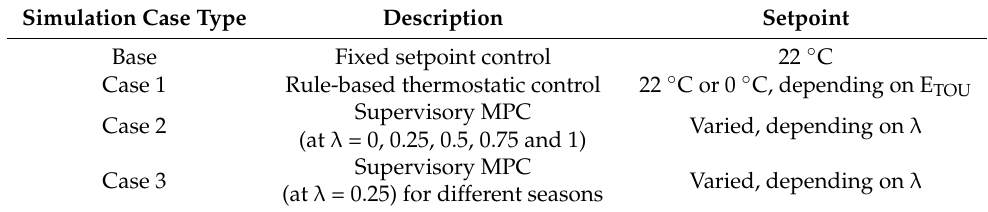
Table 1. Summary of simulation cases for HVAC